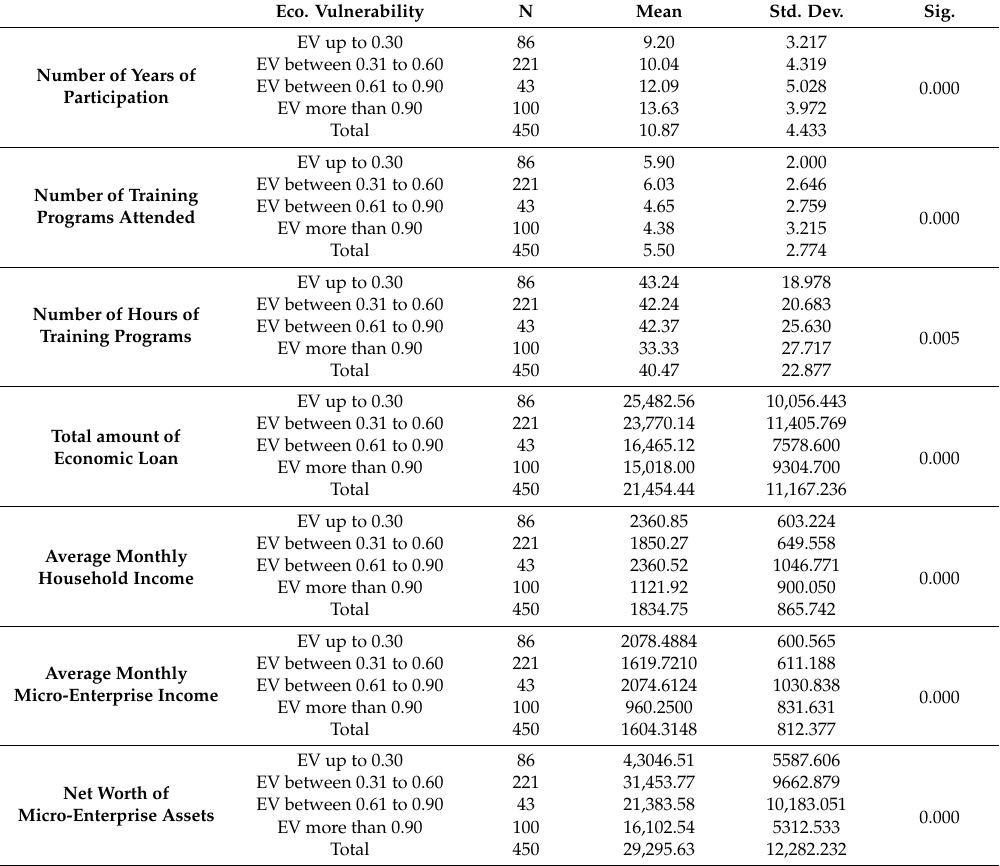
Table 3. The economic vulnerability and key